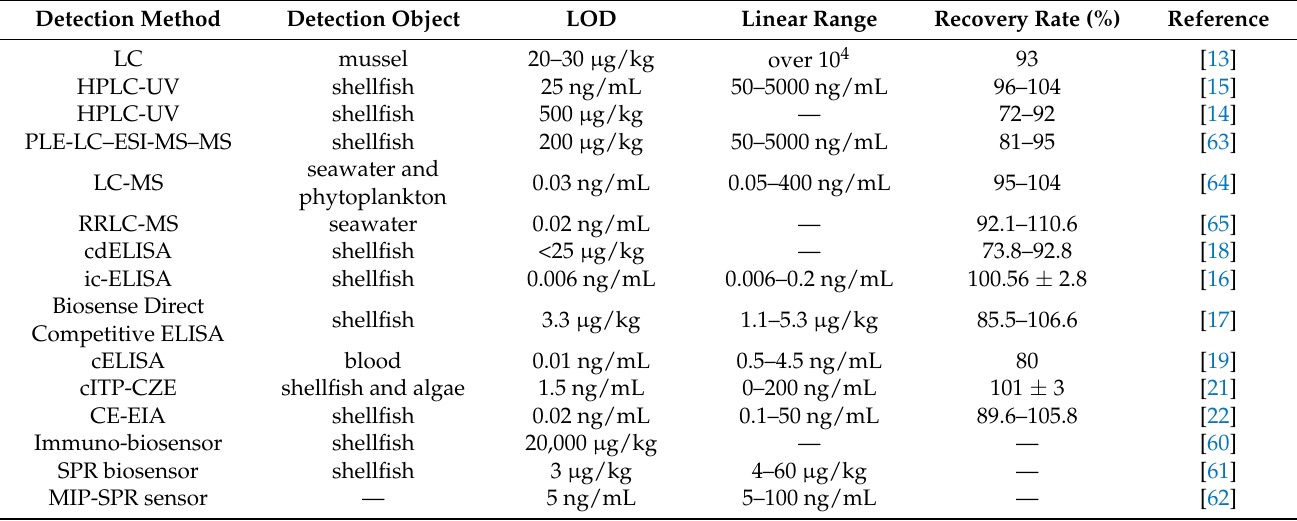
Table 4. Current detection methods of